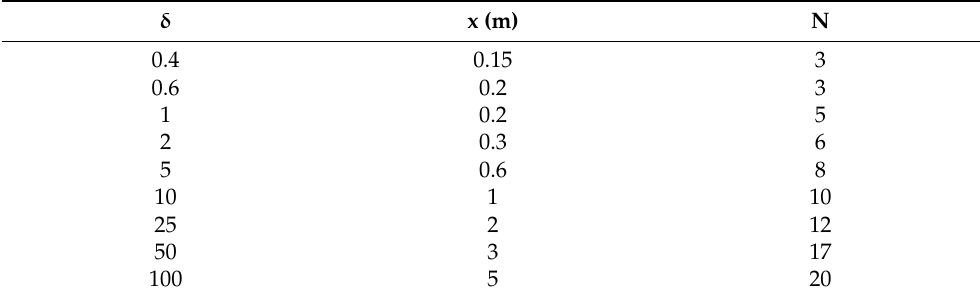
Table 1. Required uniformity in the area of the immediate surroundings based on the value in the working area [42].